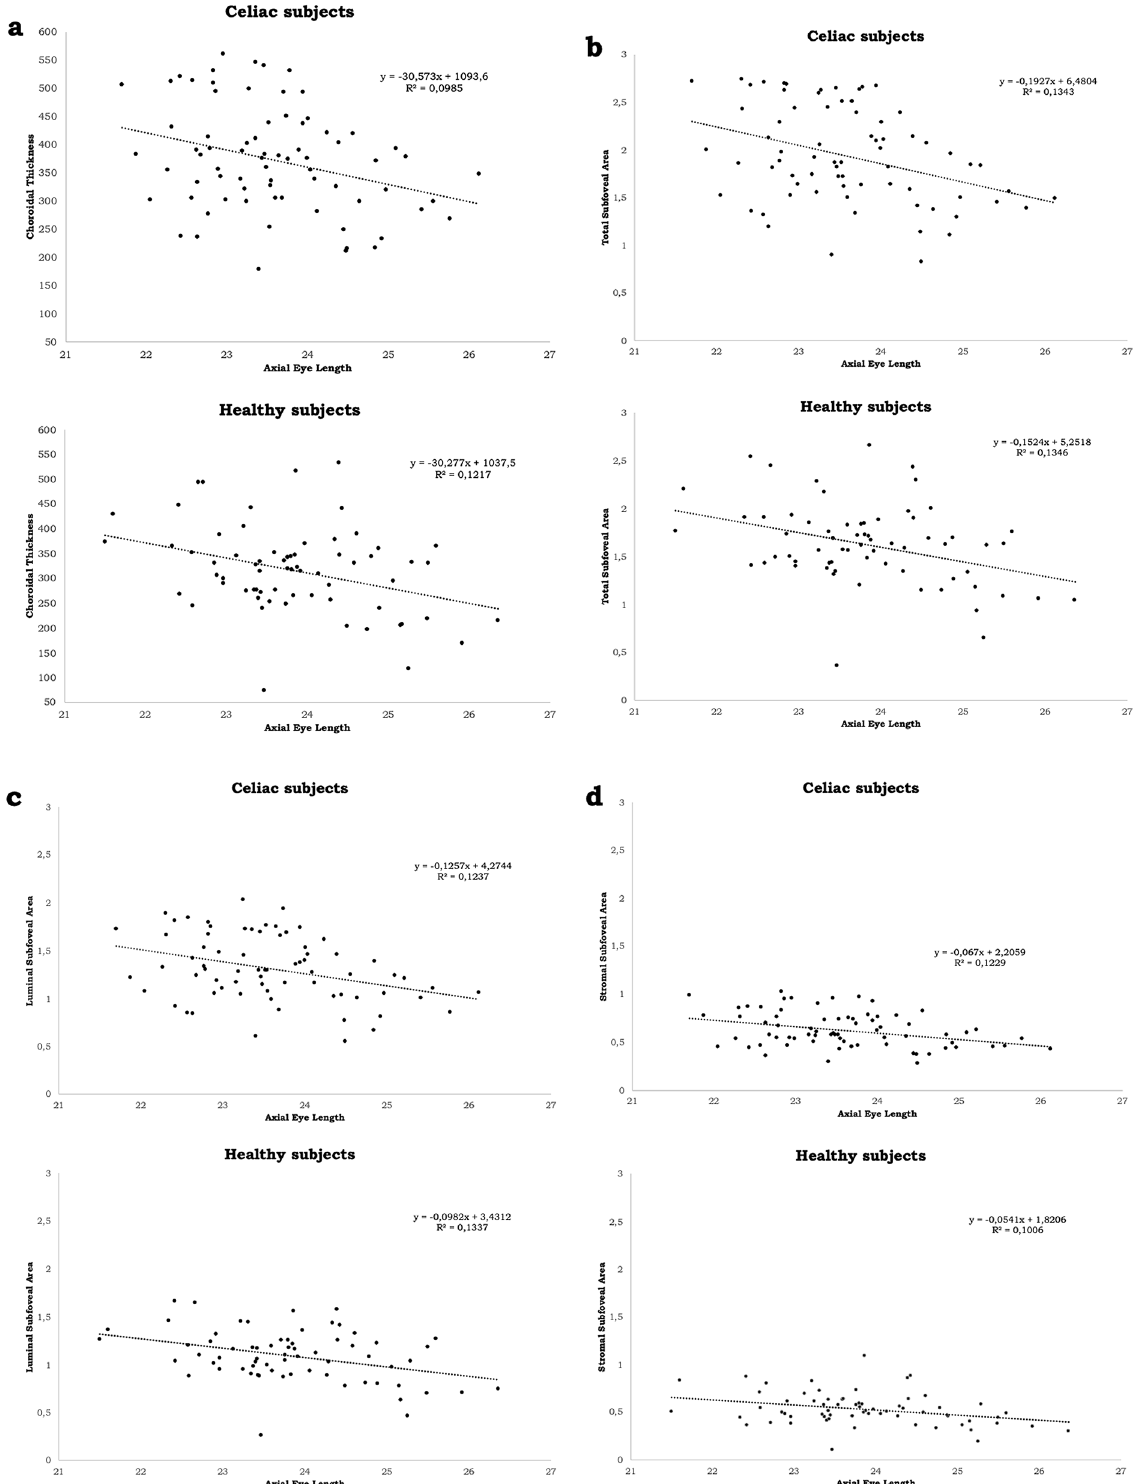
Figure 3. Scatter plot correlating axial length in the two study groups with: ( a ) subfoveal choroidal thickness ( b ) total subfoveal area. ( c ) Luminal subfoveal area. ( d ) Stromal subfoveal area. ( e ) Choroidal vascularity index. R 2 : determination coefficient. ImageJ: http:// imagej. nih. gov/ ij. GPower: https:// www. psych ologie. hhu. de/ arbei tsgru ppen/ allge meine- psych ologie- und- arbei tspsy cholo gie/ gpower.